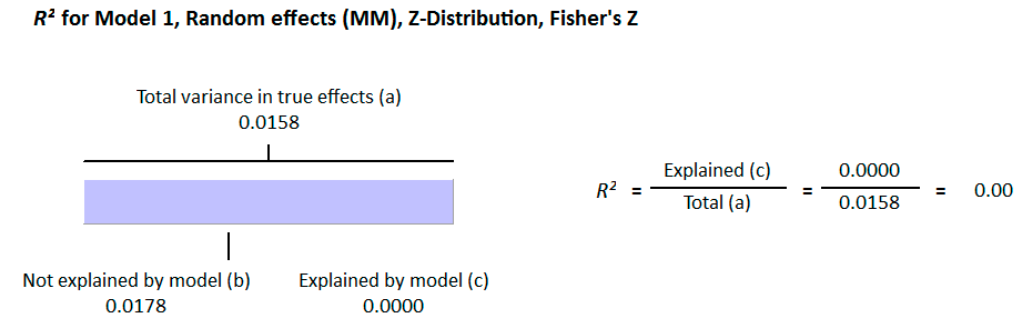
Figure 3. Meta-regression analysis for non-diabetic subject studies. Latitude R 2 shows the effect of the moderator on the heterogeneity of correlation. ( a ) total variance in true effects; ( b ) not explained by model; ( c ) explained by model.